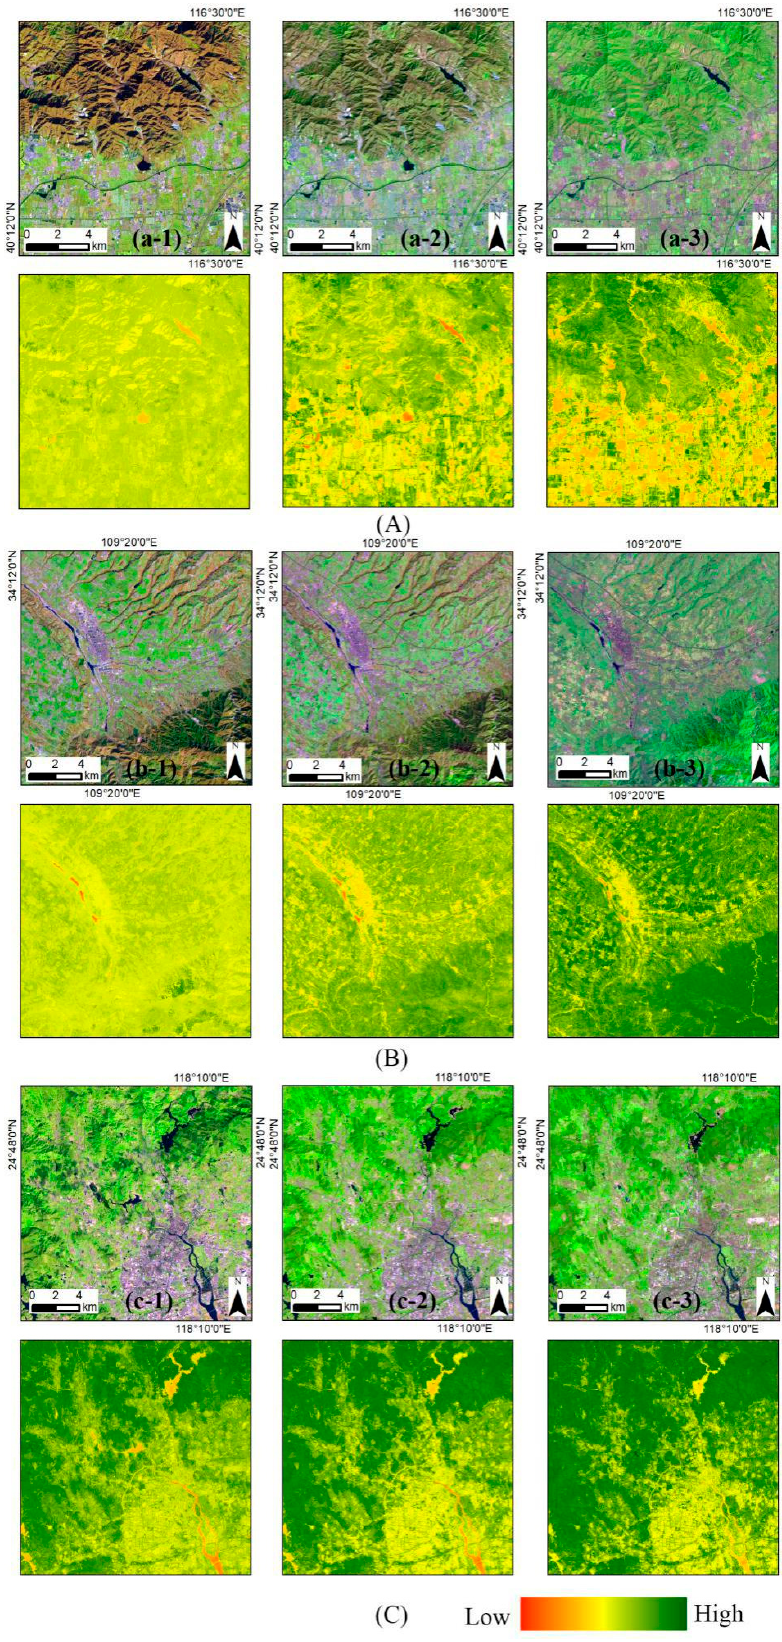
Figure 5. NDVI changes in the three study areas (( A ), ( B ), and ( C ) represent Beijing, Xi’an, and Xiamen, respectively; 1, 2, and 3 represent the results from ee.Reducer.min(), ee.Reducer.median(), and ee.Reducer.max(), respectively).